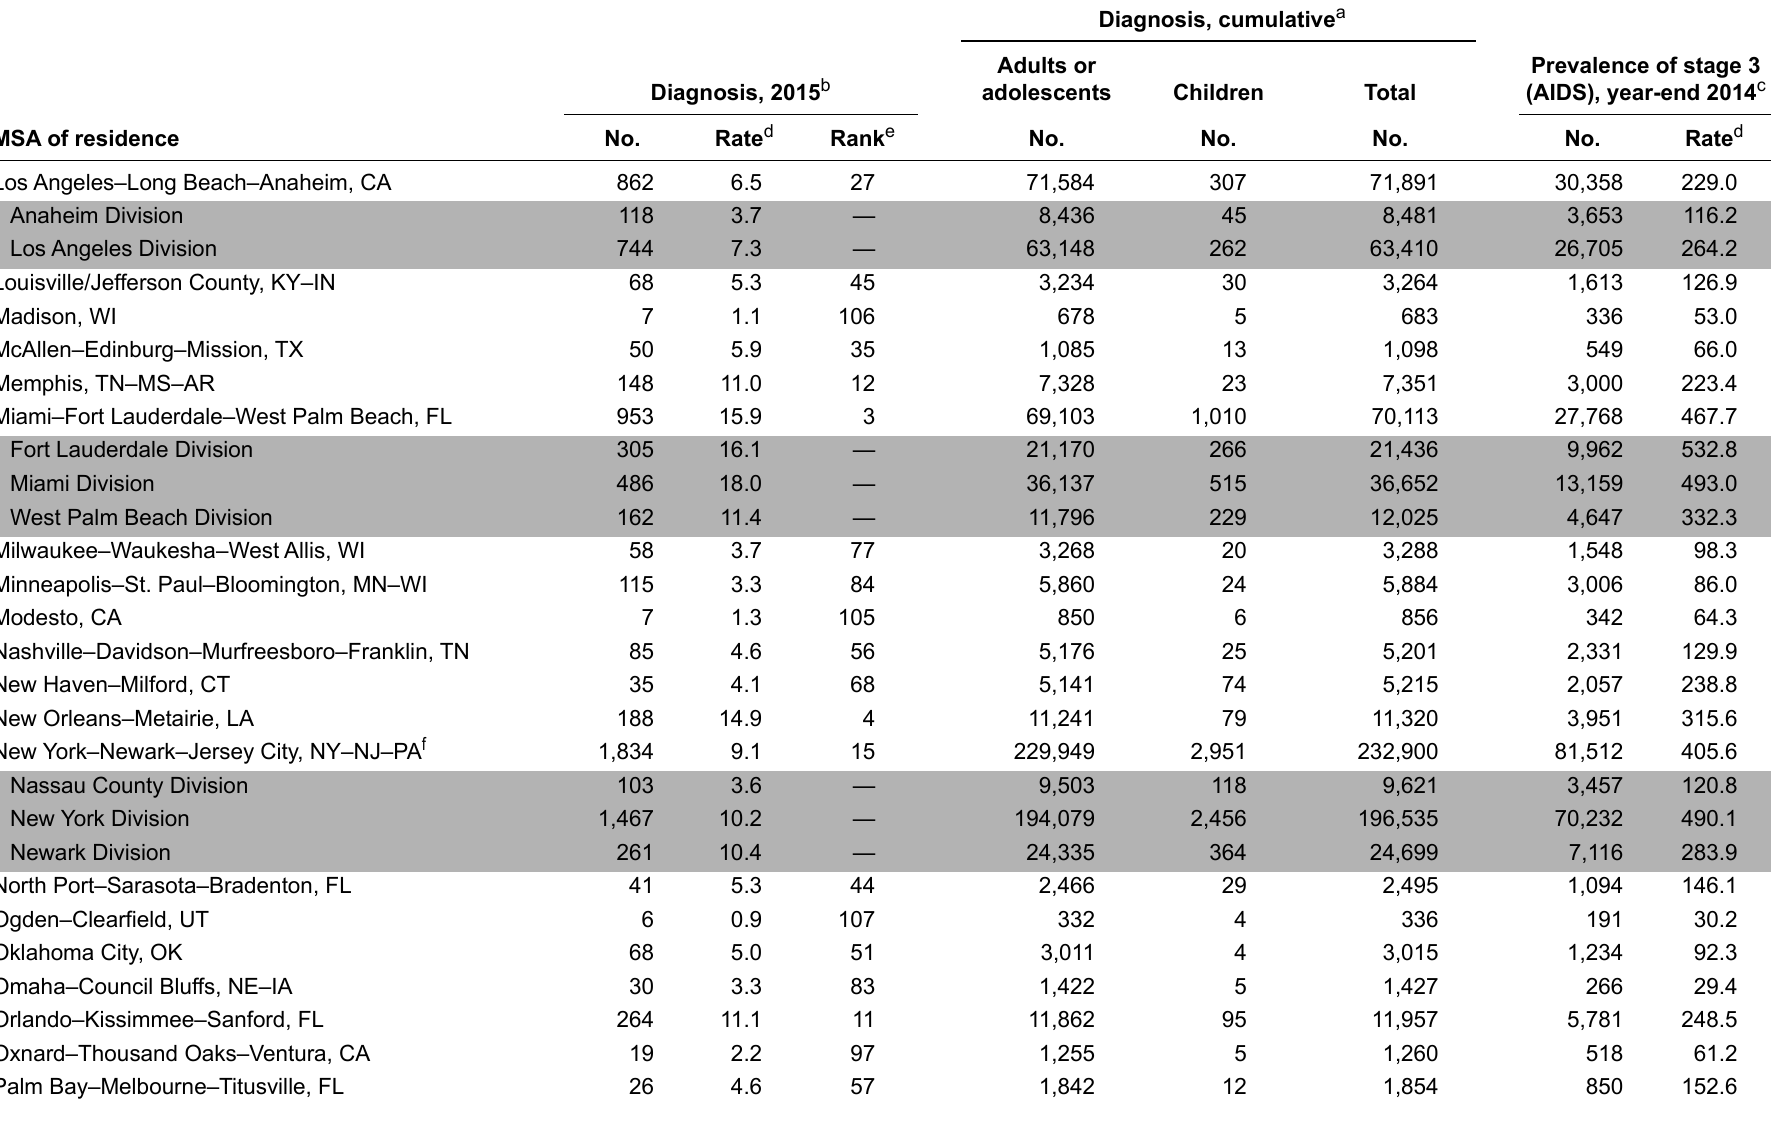
Table 27. Stage 3 (AIDS), 2015 and cumulative, and persons living with diagnosed HIV infection ever classified as stage 3 (AIDS) (prevalence), year-end 2014, by metropolitan statistical area of residence—United States and Puerto Rico